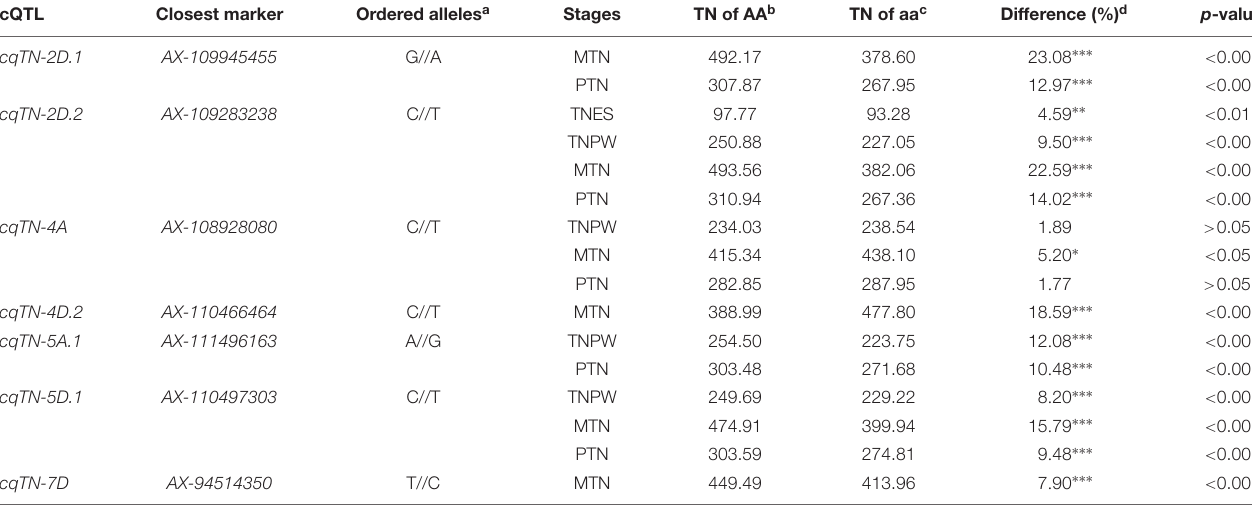
TABLE 6 | Effects of seven stable QTL in RIL population.